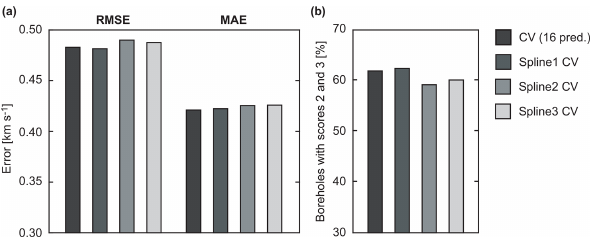
Figure 4. Comparison of (a) error metrics and (b) proportion of well-predicted boreholes (scores 2 and 3) for model runs with dif- ferent degrees of data smoothing. RMSE: root mean square error; MAE: mean absolute error; CV: cross validation.